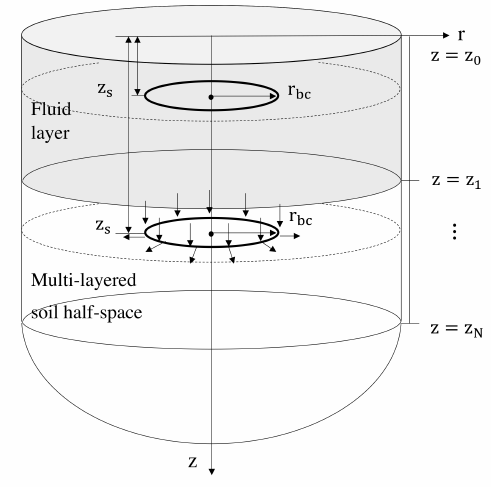
Figure 2. Schematic of the ring source at r = r bc in the configuration of acousto-elastic layered